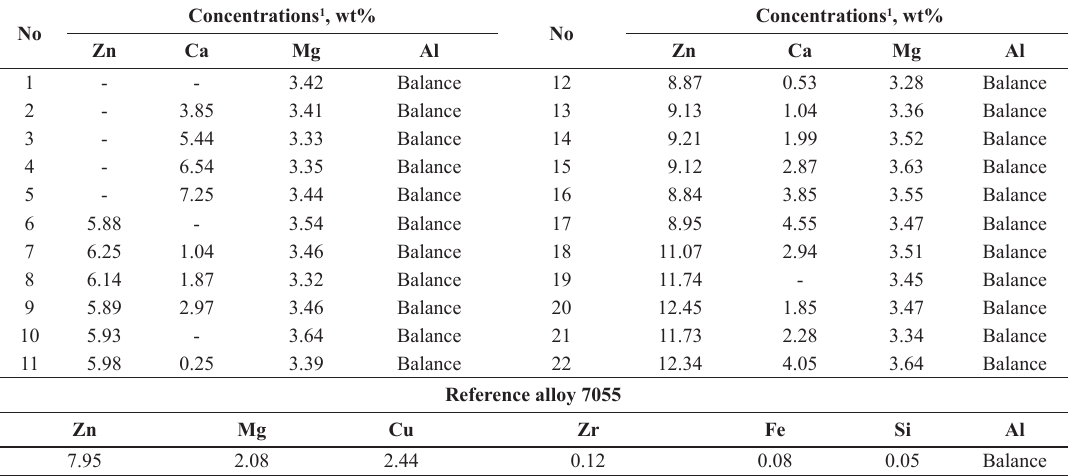
Table 1. Chemical compositions of aluminum-based alloys of the Al-Zn-Mg-Ca